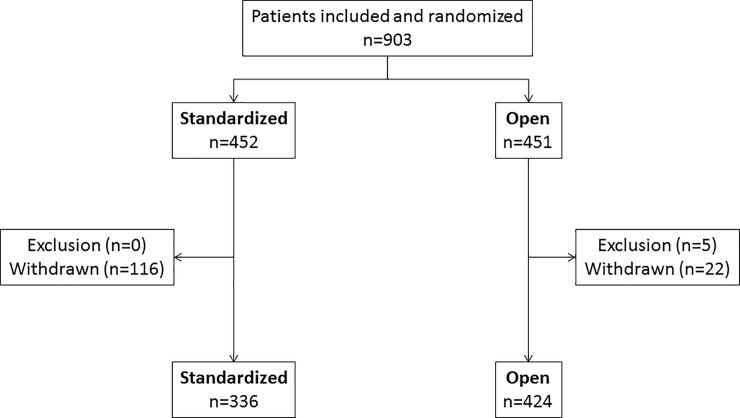
Study flow chart.